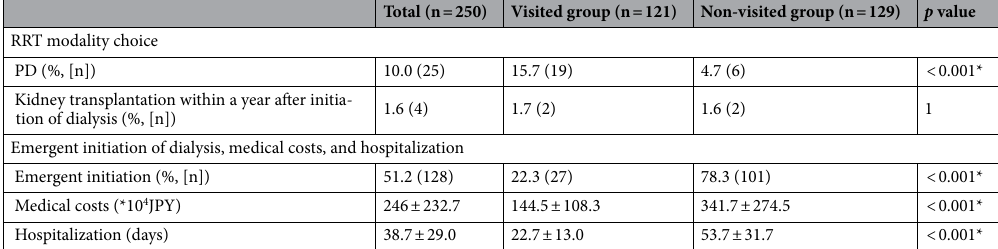
Table 5. Analyses of secondary outcomes. Data are presented as mean ± standard deviation (range) unless otherwise stated. PD, peritoneal dialysis. * p value <